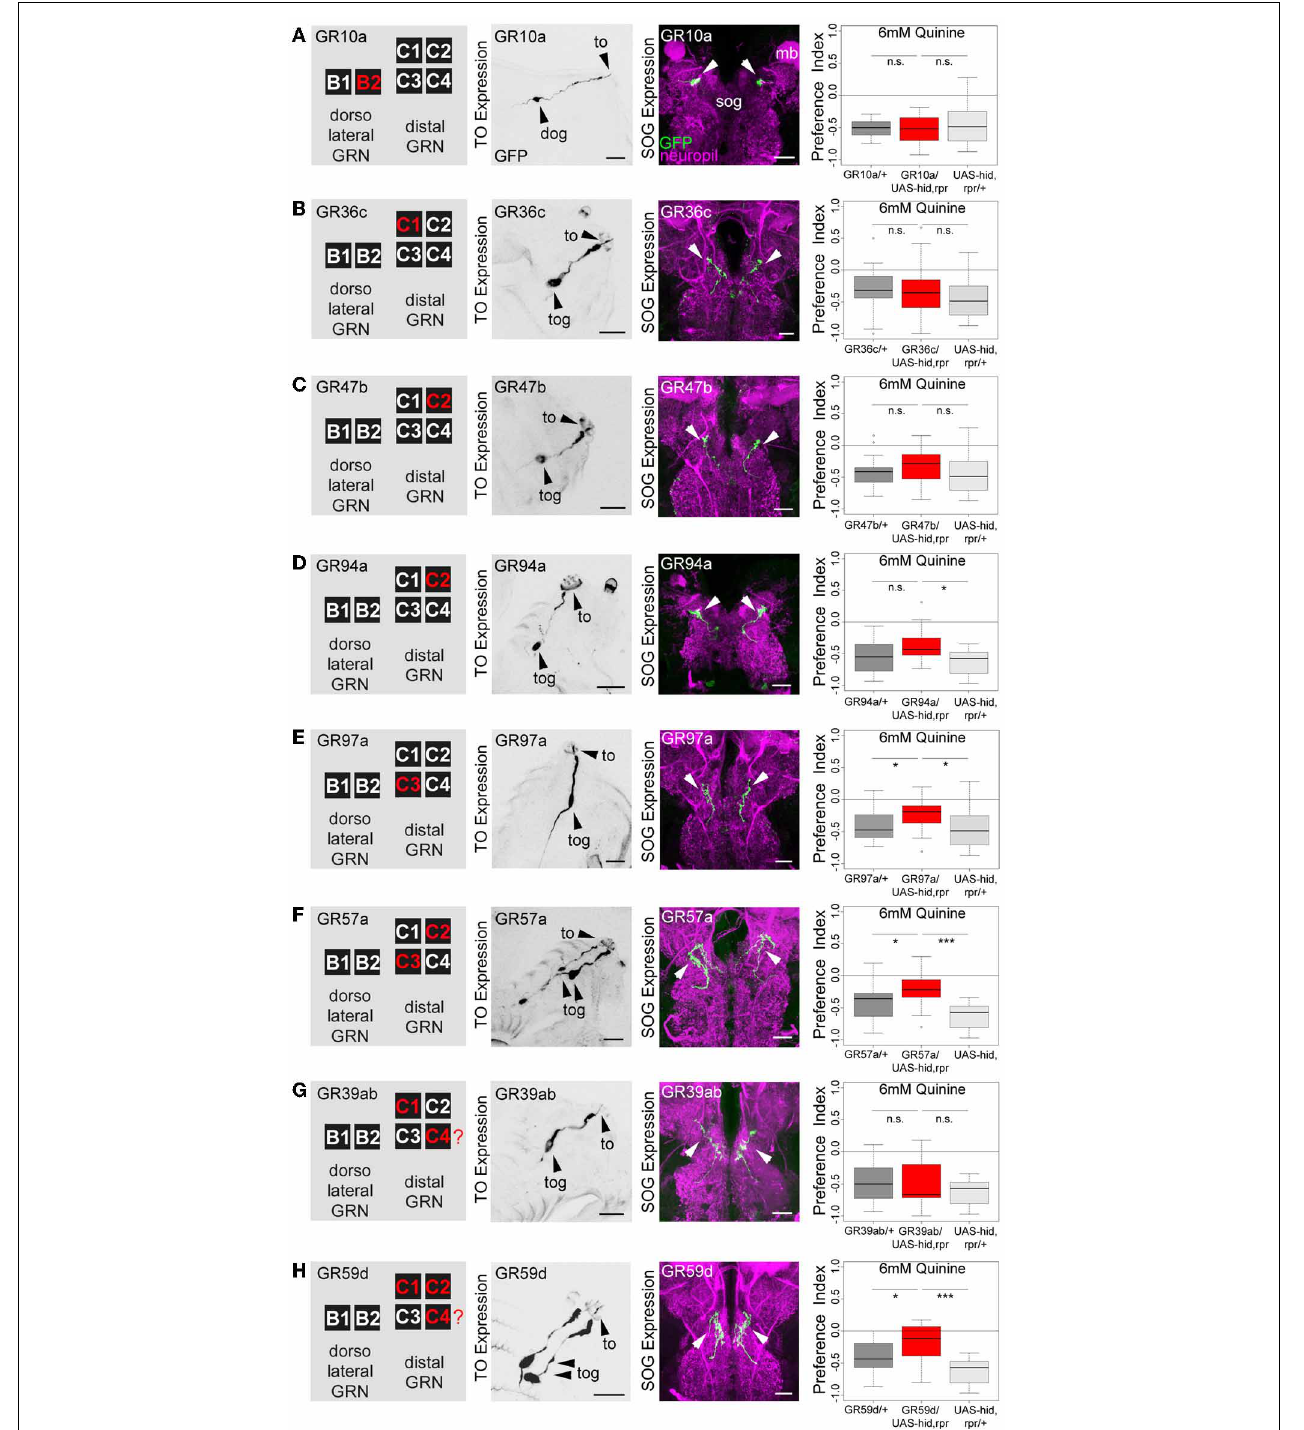
FIGURE 4 | Single TO neurons—behavior function correlation for quinine-dependent choice behavior. The first column shows a schematic overview of the respective GRNs included in the expression pattern of each GAL4 line, based on Kwon et al. (2011). The second column illustrates the expression pattern for each GAL4 line crossed with UAS-mCD8::GFP at the level of the TO (arrowheads mark the indicate the innervation of the terminal organ and the position of the respective cell body in the dorsal organ ganglion or terminal organ ganglion). The third column shows in frontal views part of